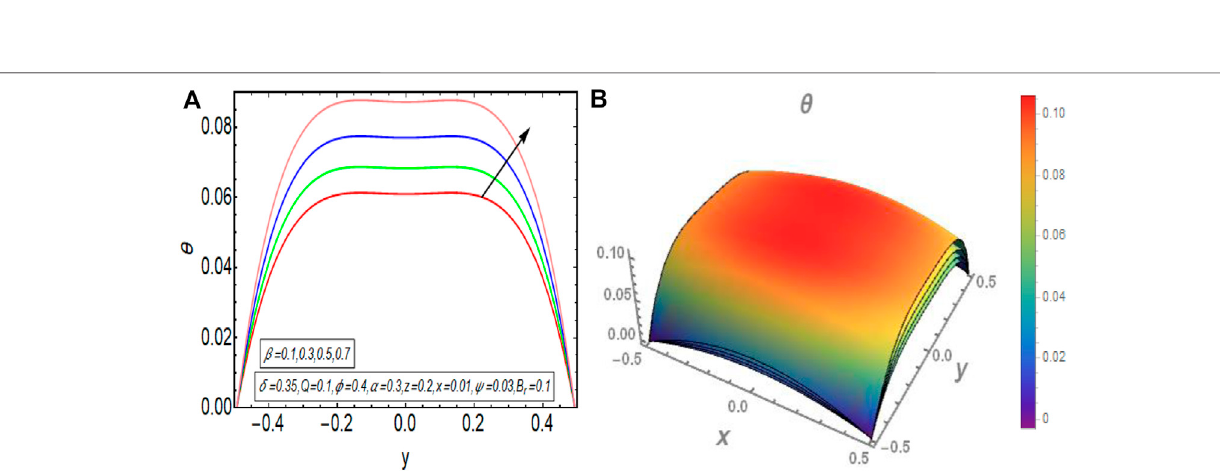
FIGURE 8 | (A) 2D-Temperature plot for wavenumber . (B) 3D-Temperature plot for wavenumber .